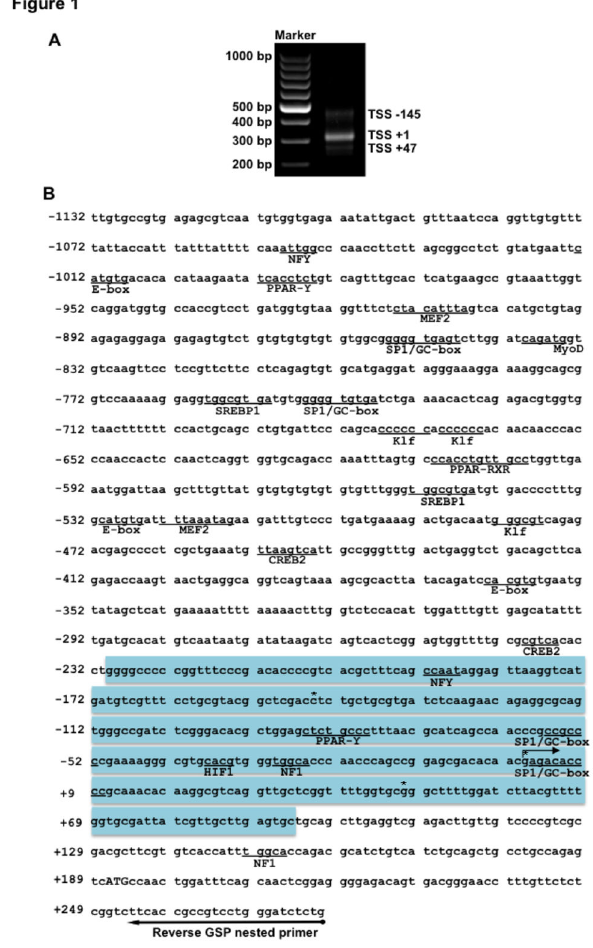
Figure 1. Analysis of the 5´ flanking region of the Fugu GLUT4 gene. (A) Determination of the transcription start sites (TSS) by 5´RACE. Agarose gel electrophoresis of nested PCR reaction products from 5´ RACE yielded three product sizes of 452, 307 and 261 bp and were denoted as -145, +1 and +47 respectively. (B) Sequence of the -1132/+277 Fugu GLUT4 promoter sequence. The three TSS are indicated with an asterisk (*). Positions are given relative to the major TSS assigned with the +1 position. The translation start codon ATG is indicated with capital letters. Putative binding sites for transcription factors are underlined. Promoter specific reverse GSP nested primer is underlined with an arrow. Blue boxes highlight the predicted CpG